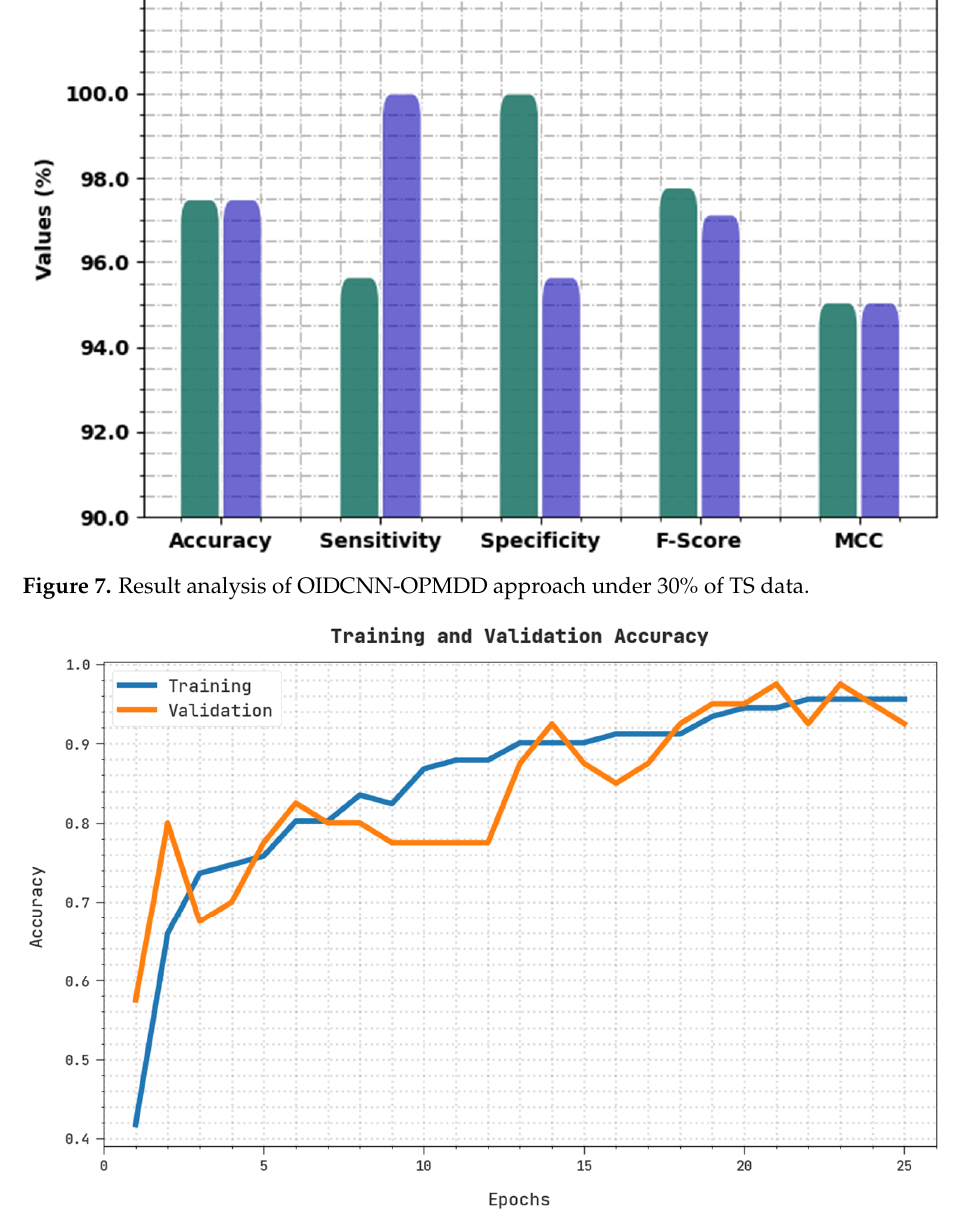
Figure 8. TRA and VLA analysis of OIDCNN-OPMDD approach.